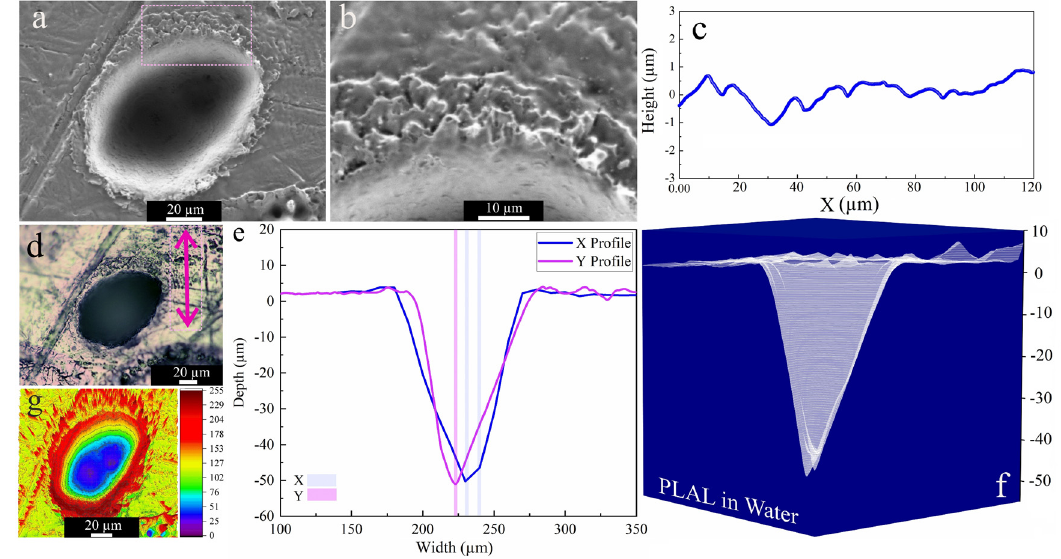
Figure 6. Morphology of a crater formed by PLAL of Au ‐ coated Ni in water ( N = 1000, 1 kHz, E = 250 μ J). ( a , b ): SEM image with a magnified area of crater edge; ( c ): a surface profile curve close to the rim; ( d ): optical microscopy of the crater (the green arrow indicates the scan of roughness); ( e , f ): depth profile analyses of femtosecond ‐ laser ‐ drilled holes and 3D mapping plot; and ( g ): 3D reconstructed image of an SEM image.